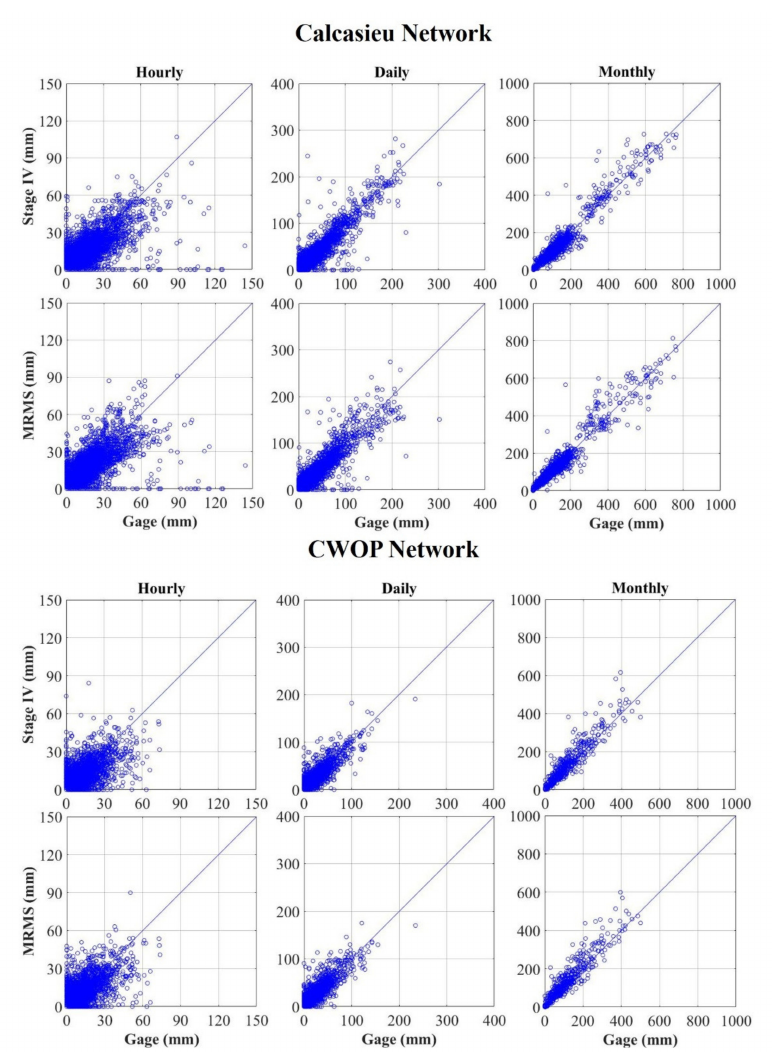
Figure 6. Scatter plots of the radar products (Stage IV and MRMS) versus surface reference rainfall for the Calcasieu network (top panel) and Citizen Weather Observation Program (CWOP), (bottom panel), at hourly (left), daily (middle), and monthly (left)